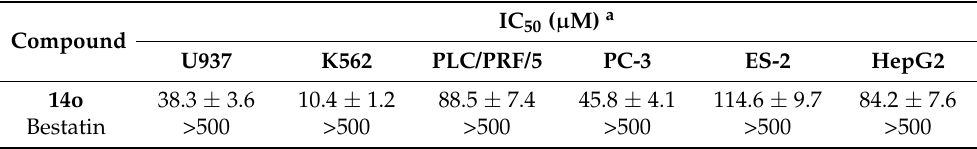
Table 2. In vitro anti-proliferative activities of selected compounds against tumor cells. Compound